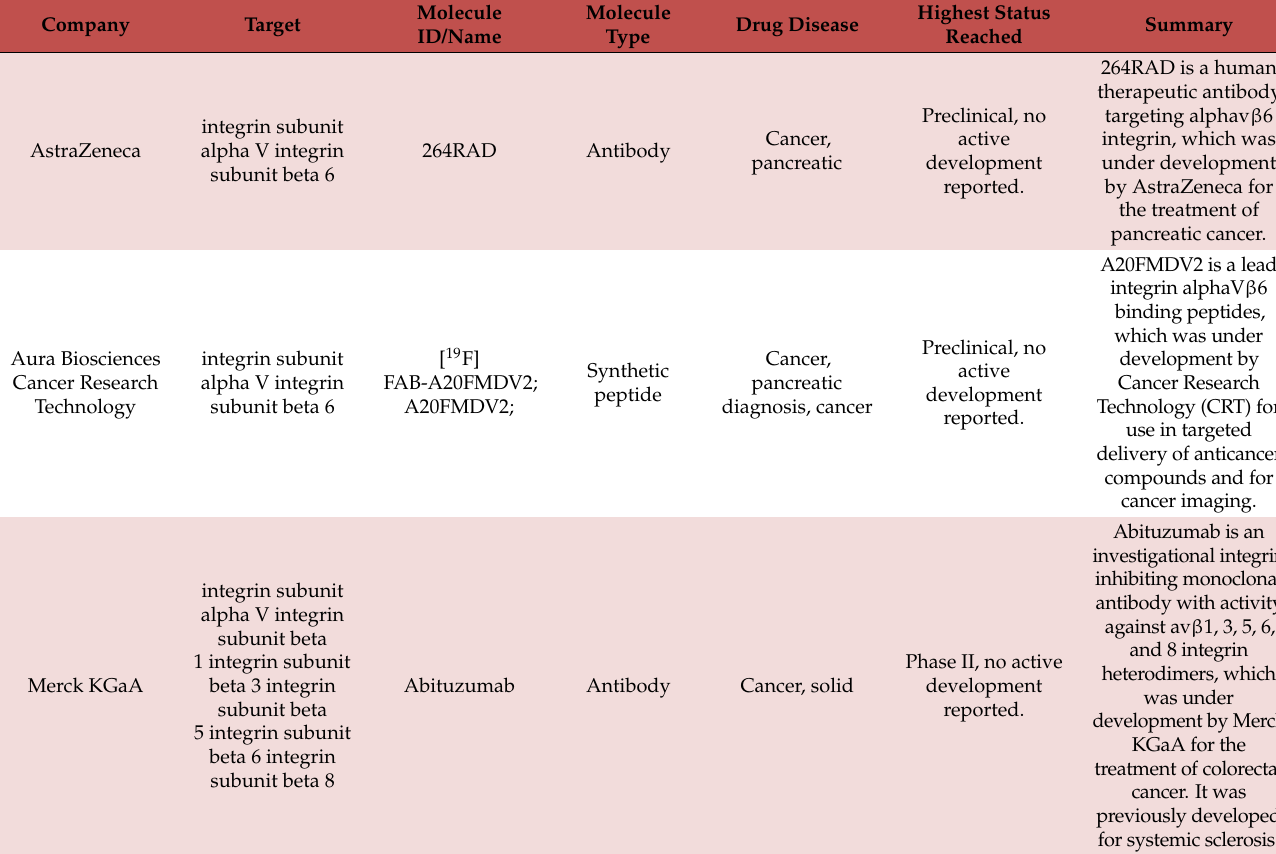
Table 2. Summary of drugs targeting α v β 6 in various stages of clinical development. Retrieved